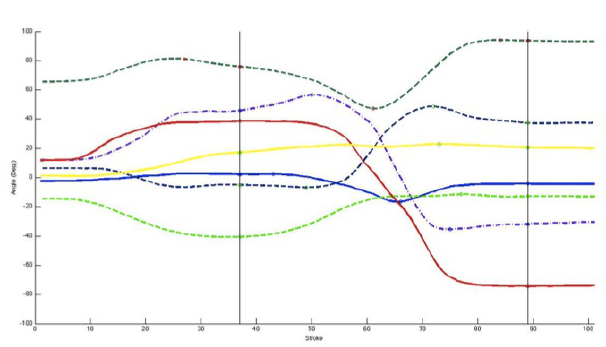
Figure 7. The signals for different segments of the upper limb. For the hand, supination/pronation in red, abduction/adduction in sky blue and dotted purple for flexion/extension. For the forearm, extension/flexion in dotted dark green. For the arm, internal/external rotation in dotted dark blue, abduction/adduction in dotted green and extension/flexion in yellow. Vertical lines indicate the highest variation in prono-